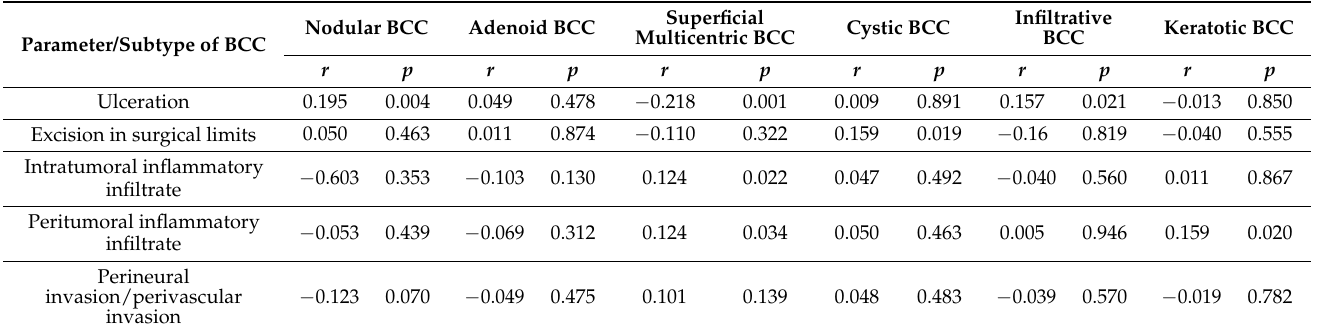
Table 8. Correlation of the histopathological parameters with the incidence of the six histopathological BCC subtypes.